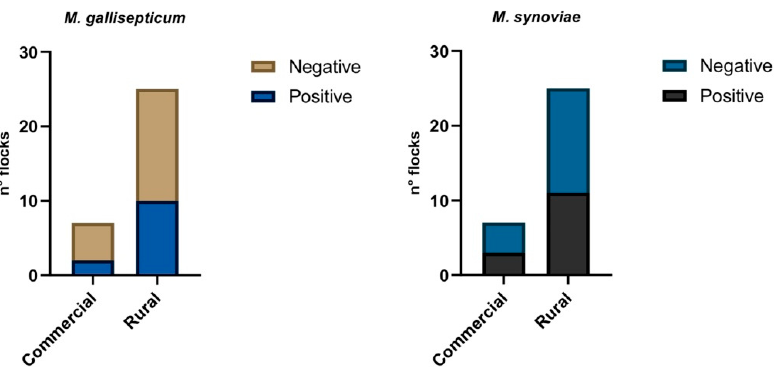
Figure 2. Molecular results obtained by duplex real time PCR to evaluate the presence of MS and MS DNA in sampled flocks.